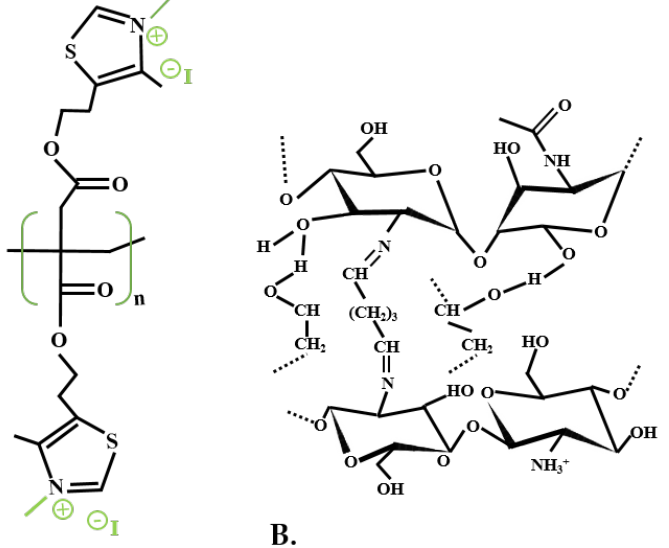
Figure 9. IA-based intelligent food packaging ( A ). Quaternized polymer with thiazole groups and gelatin film (adapted after [150]) ( B ). Crosslinked poly(vinyl alcohol), chitosan and IA (adapted after [110]).